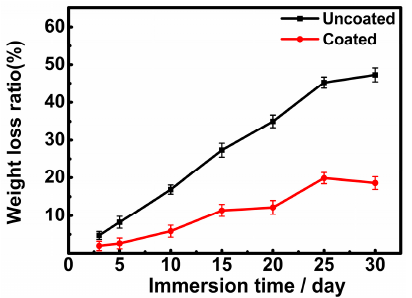
Figure 5. Changes in weight loss rate of the samples over